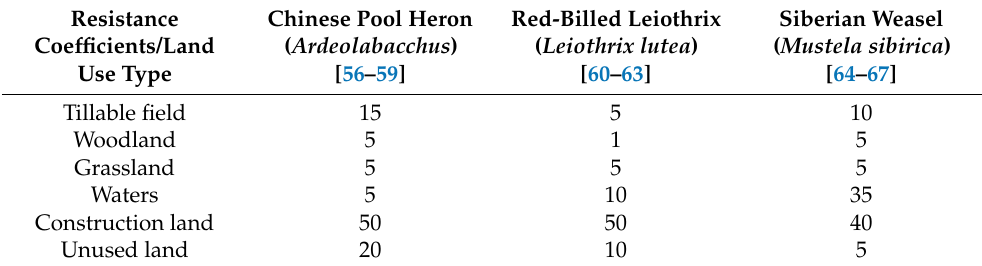
Table 1. Relative resistance coefficients of indicator species (0–100).